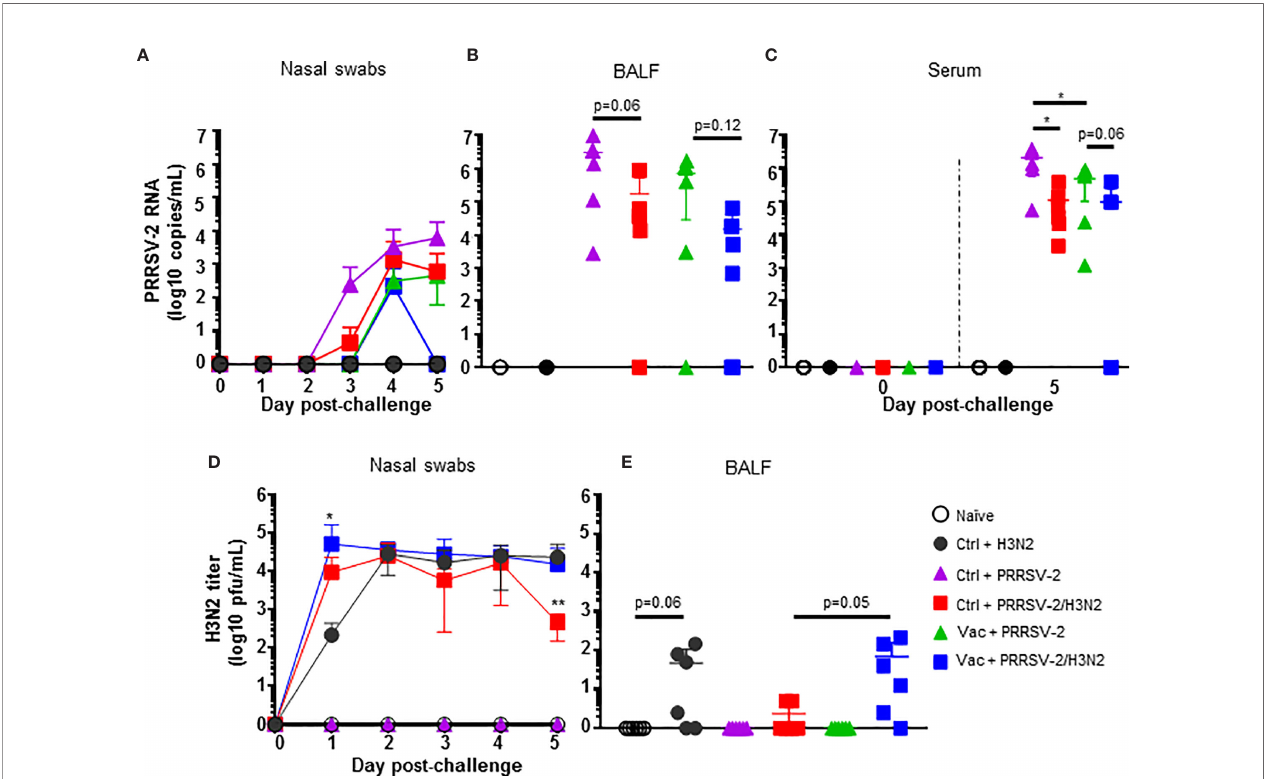
FIGURE 2 | PRRSV-2 and H3N2 loads. Quanti fi cation of PRRSV-2 viral RNA in nasal swabs (A) , BALF (B) and serum (C) were determined by qRT-PCR. H3N2 titers in nasal swabs (D) and BALF (E) were determined by plaque assay. The mean values (A, D) or individual values (B – E) for each group ± SD are indicated (n = 6 per group). P values were determined using Mann-Whitney test and asterisks indicate signi fi cant differences (*p < 0.05; **p <